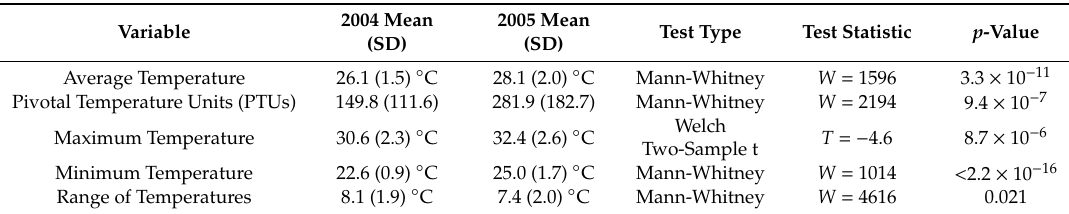
Table 2. Results from statistical tests comparing nest temperature measurements during the temperature-sensitive period for diamondback terrapins ( Malaclemys terrapin ) in a particularly cool, wet year (2004) and a hot, dry year (2005).